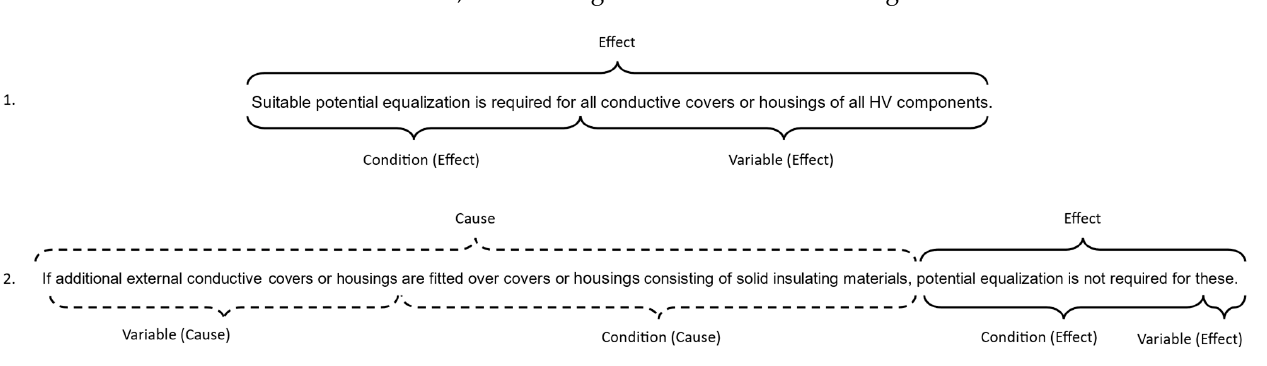
Figure 10. Building blocks for an Alius Contradictory contradiction, consisting of two requirements.